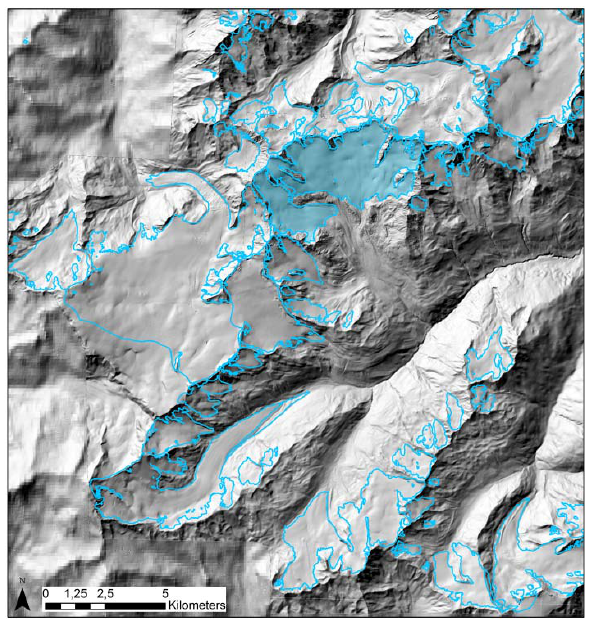
Figure 1. Digital Elevation Model (composite of the airborne laser scanning DEM (Abermann et al., 2012) and SRTM DEM) of the Hinteres Oetztal with the glacier boundaries whereas the Vernagtferner is colored in blue (Abermann et al.,